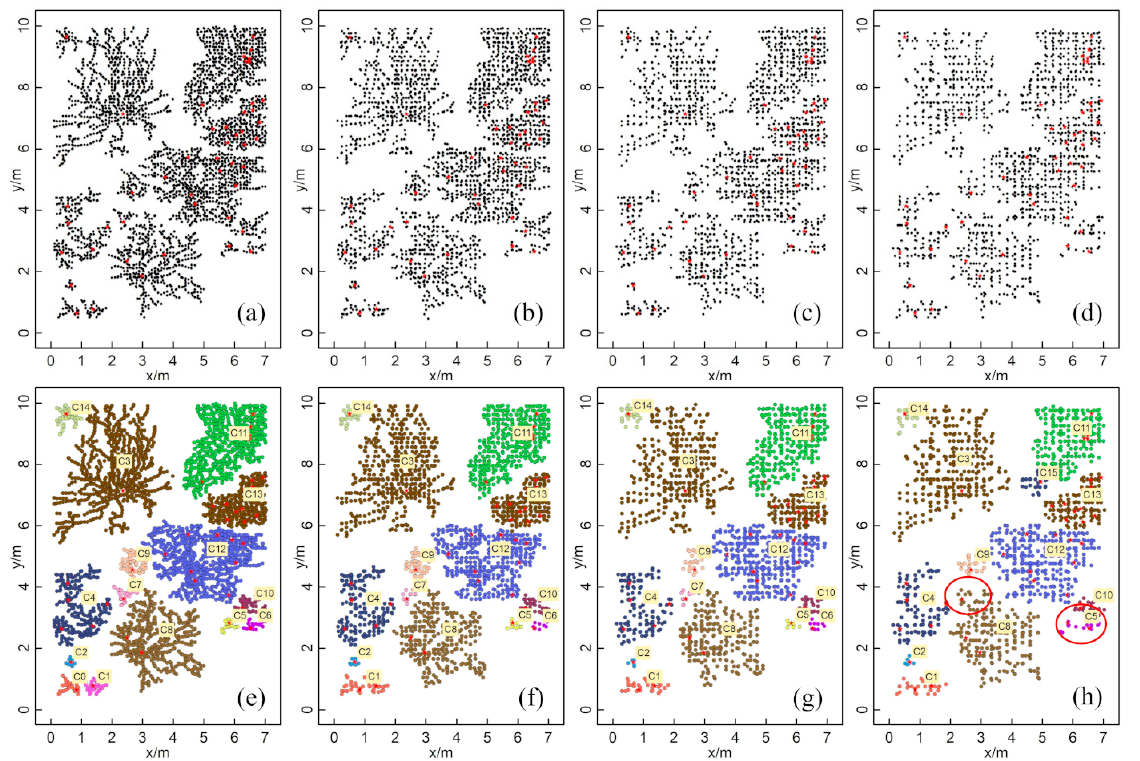
Figure 8. Root points extracted by the simulated GPR survey and ZOI generated by the HDBSCAN algorithm at different line intervals: ( a , e ) 10 cm; ( b , f ) 15 cm; ( c , g ) 20 cm; ( d , h ) 25 cm. Different colors represent different ZOIs and are labeled with yellow labels. The red star points are the plants’ centers.